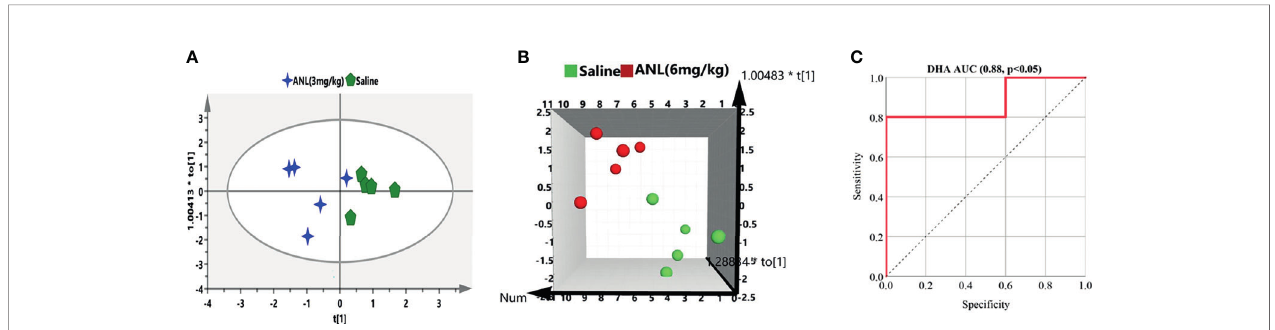
FIGURE 7 | The OPLS-DA to differentiate the ef fi cacy groups based on the screened biomarkers. Green shape marks indicate mice treated by saline (A) or (B) , blue stars mean mice treated by ANL [3 mg/kg, (A) ], and red circle represents mice treated by ANL [6 mg/kg, (B) ]. (C) The ROC curve of DHA for the ANL (6 mg/kg) group.